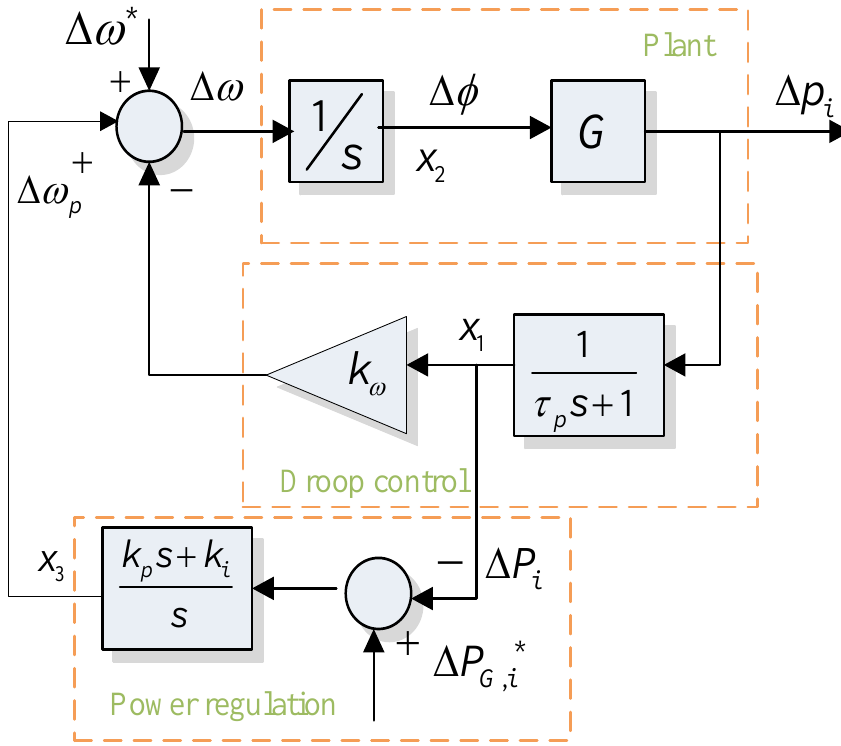
Figure 4. Block diagram of small signal model of the power regulation.